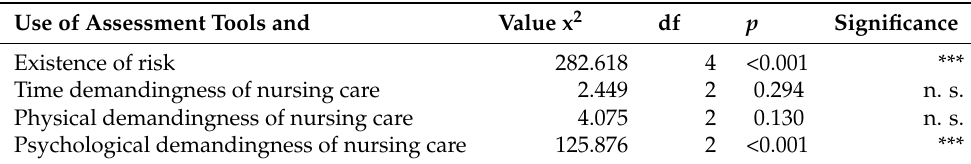
Table 4. Correlations between the use of assessment scales and the demandingness of care. Use of Assessment Tools